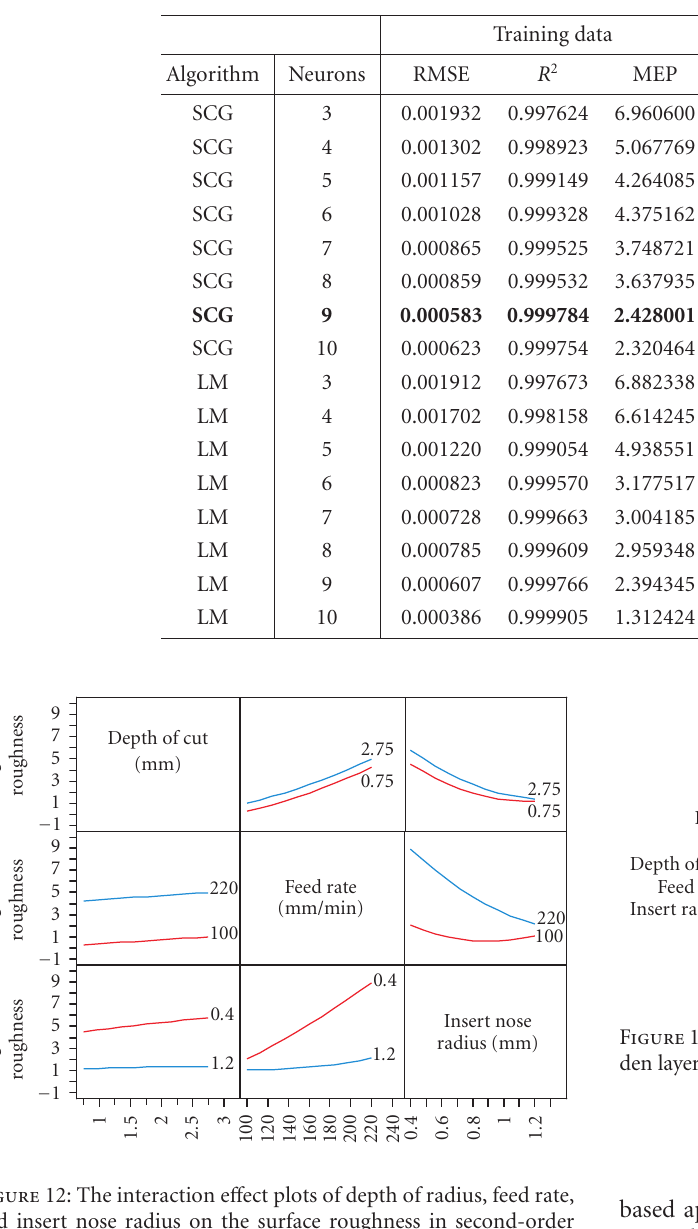
Table 11: Statistical errors for the surface roughness using various algorithms.